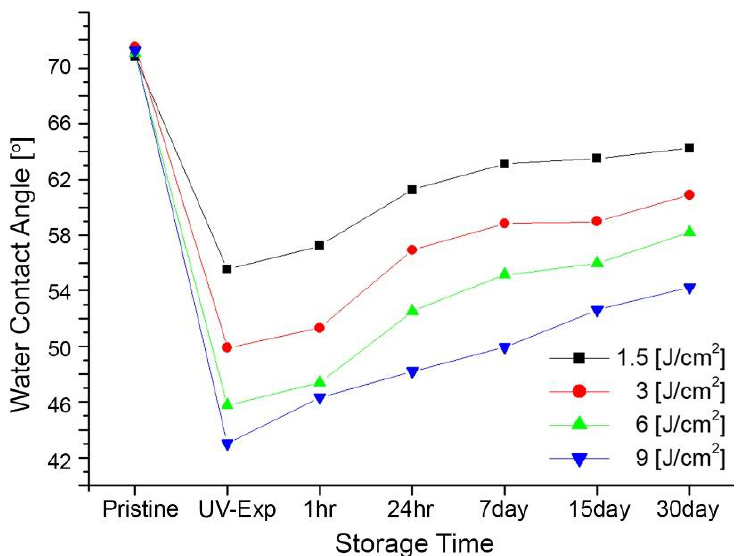
Figure 5. Average change in water contact angles of PMMA surface by storage time after UV exposure without IPA rinsing.